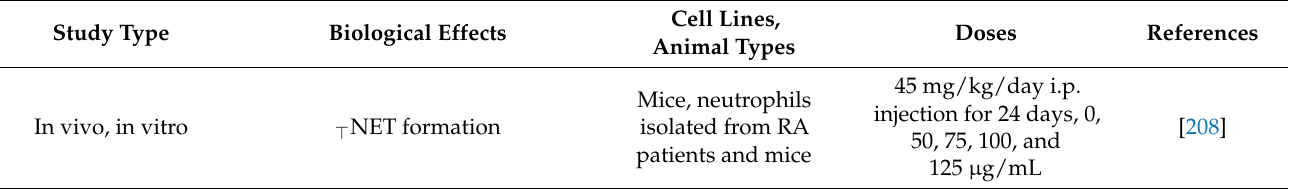
Table 7. Effects of polydatin on rheumatoid